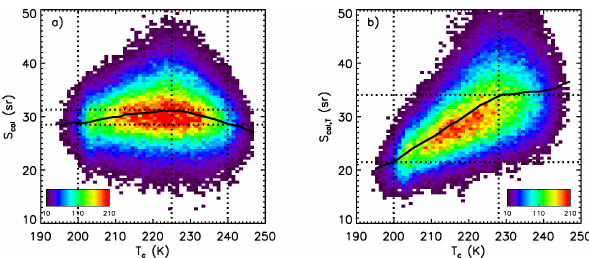
Figure 11. Two-dimensional histogram of (a) τ vis ( η = 0.6) and (b) τ vis , T ( η T from this study), and centroid temperature T c . The color code is the number of samples. Same data set as in Fig. 9.